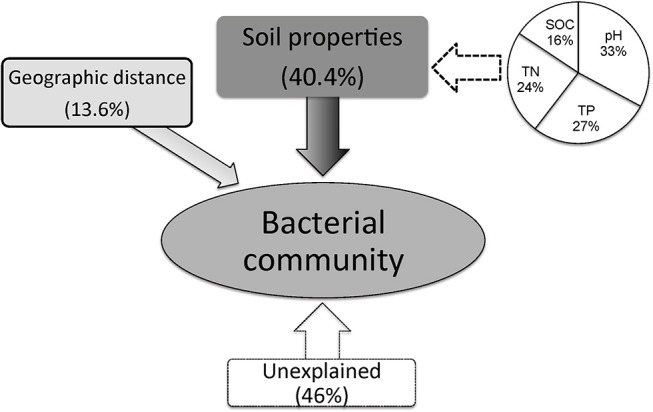
Variation partition analysis of the effects of soil properties and geographic distance on the phylogenetic structure of soil bacterial communities.